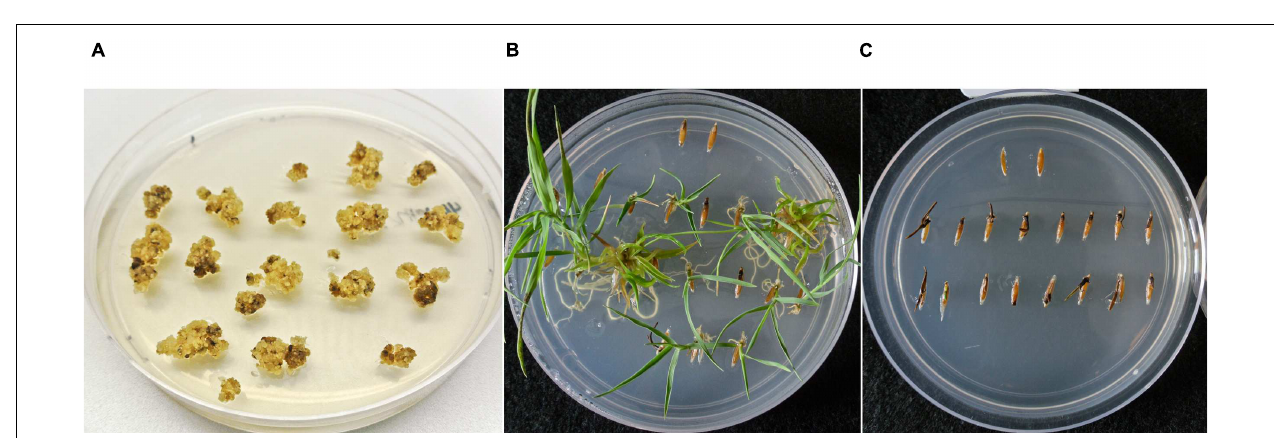
FIGURE 1 | Transfer DNA (T-DNA) region of the pARS1-RUBQ2-GUSPlus, pARS2-ZmUbi1-1.6 kb and pARS3m-ZmUbi1-GUSPlus binary vectors. (A) The pARS1-RUBQ2-GUSPlus 8004 bp T-DNA with the synthetic GUSPlus reporter gene (Broothaerts et al., 2005) under control of the Rice Ubiquitin 2 ( RUBQ2 ) promoter (pro) – intron – monomer (m) (Wang et al., 2000) and terminated with the nopaline synthase ( nos ) terminator (t 2 ) is shown. The coding sequence for the RUBQ2 ubiquitin monomer (m) is translationally fused to GUSPlus . The neomycin phosphotransferase II ( nptII ) paromomycin resistance marker gene is under control of the Maize Ubiquitin 1 ( ZmUbi1 ) promoter and intron (Christensen and Quail, 1996) with polyadenylation directed by the Cauliflower Mosaic Virus ( CaMV ) 35S terminator (t 1 ). (B) The pARS2-ZmUbi1-1.6 kb 8200 bp T-DNA with a B. distachyon cDNA under control of the ZmUbi1 promoter and intron and terminated with the nos terminator (t 2 ) is shown. The RUBQ2 ubiquitin monomer (m) is translationally fused to the nptII paromomycin resistance marker gene and terminated by the CaMV 35S terminator (t 1 ). (C) pARS3m-ZmUbi1-GUSPlus vector contains a 7757 bp T-DNA of with the GUSPlus gene under control of the ZmUbi1 promoter and intron and the nos terminator (t 2 ). The RUBQ2 promoter – intron – monomer is translationally fused to the hygromycin phosphotransferase II ( hptII ) resistance gene and terminated with the CaMV 35S terminator (t 1 ). The 5 (cid:48) UTR (u) of each promoter is indicated. Each T-DNA is delineated by the right (RB) and left (LB) borders from the Ti plasmid of A. tumefaciens strain C58. Intron 1 (i) of the Ricinus communis Catalase 1 gene (Suzuki et al., 1994) in GUSPlus ensures that any plant tissue that exhibits β -glucuronidase activity is due to eukaryotic (spliced) expression of GUSPlus .